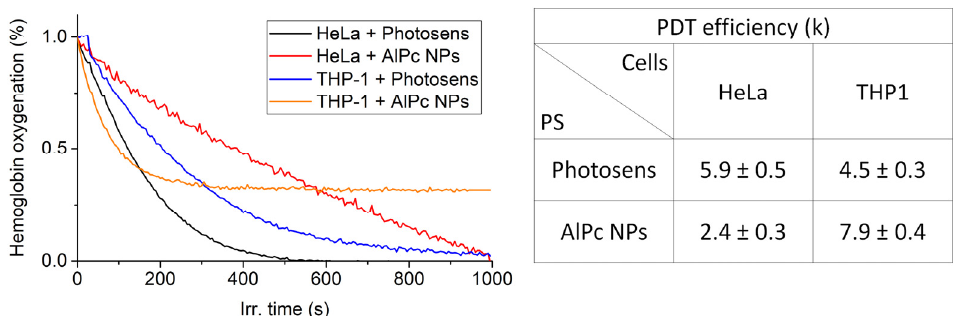
Figure 7. Dependence of hemoglobin oxygenation in the sample on the duration of laser irradiation at a wavelength of 675 nm with a power density of 200 mW/cm 2 for HeLa and THP-1 cells incubated with AlPc NPs and Photosens, as well as the calculated values of photodynamic efficiency coefficient (k).